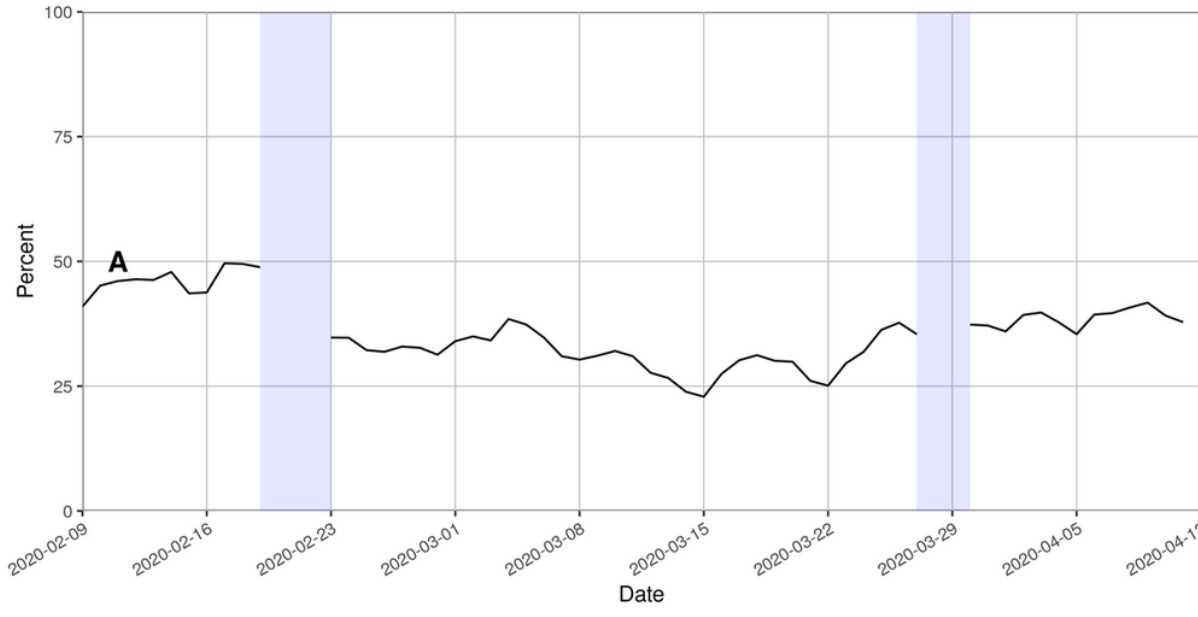
Figure 6. The relative proportion of tweets with links to external resources. The capital letter "A" represents the naming of the disease by the World Health Organization on February 11, 2020. Blue rectangles: No tweets were collected between February 20 and 22 as well as between March 28 and 29 due to technical